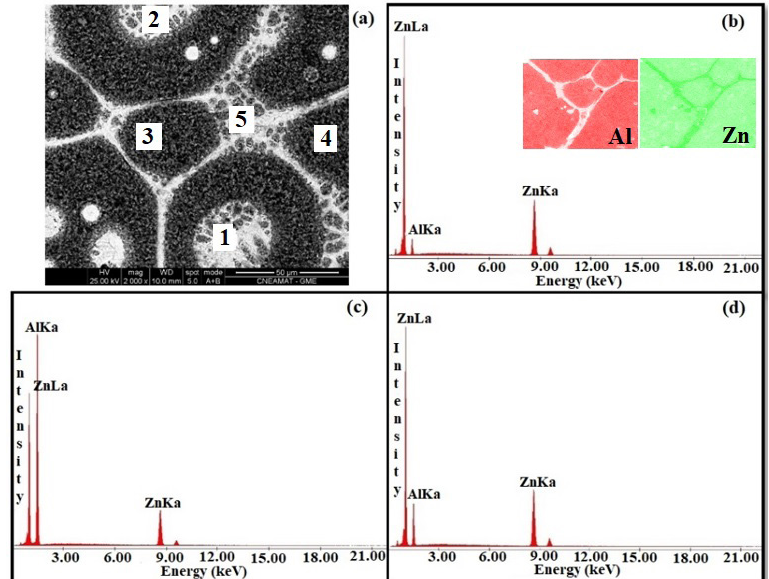
Figure 7. SEM images of ZA27 alloys during 20 min at 460 °C: (a) the pure ZA27 alloy with the measuring points by EDAX: (1-2) Intraglobular, (3-4) Globular and (5) Interglobular. (b) EDS spectra of interglobular zone with micrograph of mapping of elements, (c) EDS spectra of globular zone and (d) EDS spectra of intraglobular zone.